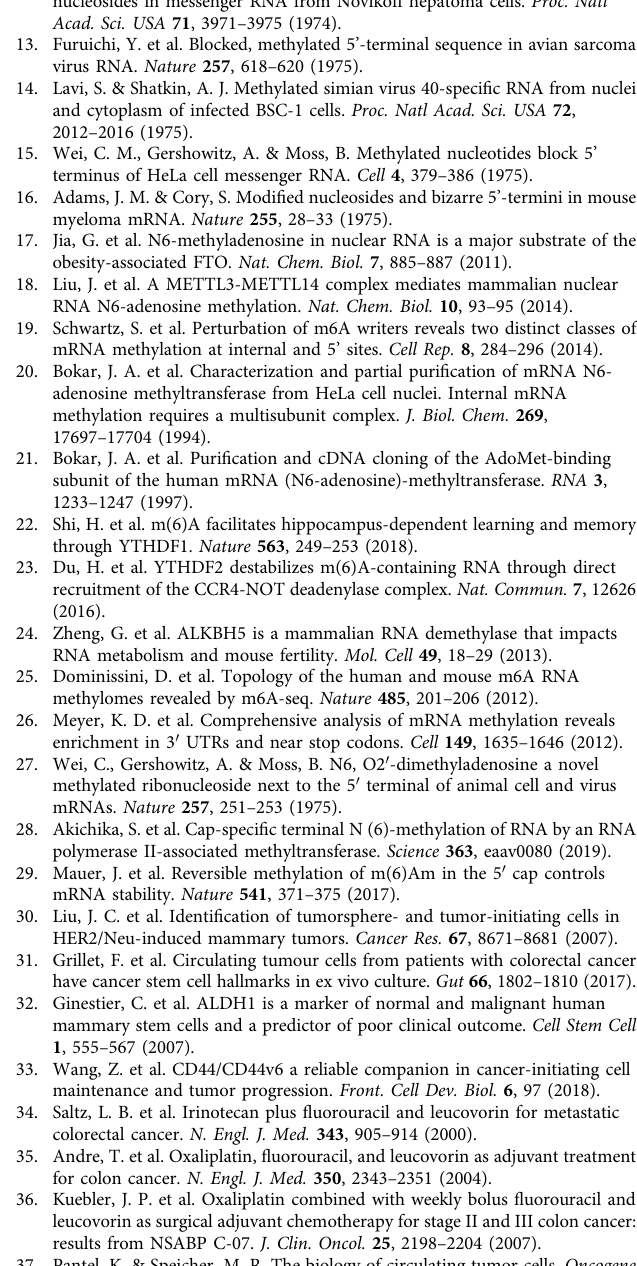
Fig. 5 FTO mediated m 6 A m demethylation takes place in the cytoplasm. a FTO localizes both in nucleus and cytoplasm. Immuno fl uorescence staining of FTO (green) in CRC1 and SW620 cell lines show presence of FTO in cytoplasm and in nuclear speckles. Nucleus of cells were stained with Hoechst (blue). Pictures are representative of several fi elds and two biological experiments. Scale bar 10 μ m. b Veri fi cation of the effective cell fractionation procedure by immunoblot. Effective separation of cytoplasmic and nuclear fractions was evaluated by immunoblot using cytoplasmic marker (GAPDH) and nuclear marker (Histone H1). c FTO silencing increases cytoplasmic m6Am level. mRNA quanti fi cation of m 6 A m /A and m 6 A/A level for nuclear fraction and cytoplasmic fraction. Bar plots represents mean ± S.E.M of three biological replicates. Before – After plots represents the same data as bar plot with raw values. d FTO relocalizes to the cytoplasm during tumorigenesis. FTO expression and localization was evaluated by IHC on TMA from CRC patient. Then, nuclear and cytoplasmic level of FTO were quanti fi ed. Pictures are representative of stage 0 and stage 2. Scale bars 100 µ m and 10 µ m (zoom). Bar plots represents mean ± S.E.M of H -score based on nuclear and cytoplasmic intensity of FTO staining. Each dot corresponds to individual value. * p -value < 0.05, ns not signi fi cant, two-tailed Mann – Whitney